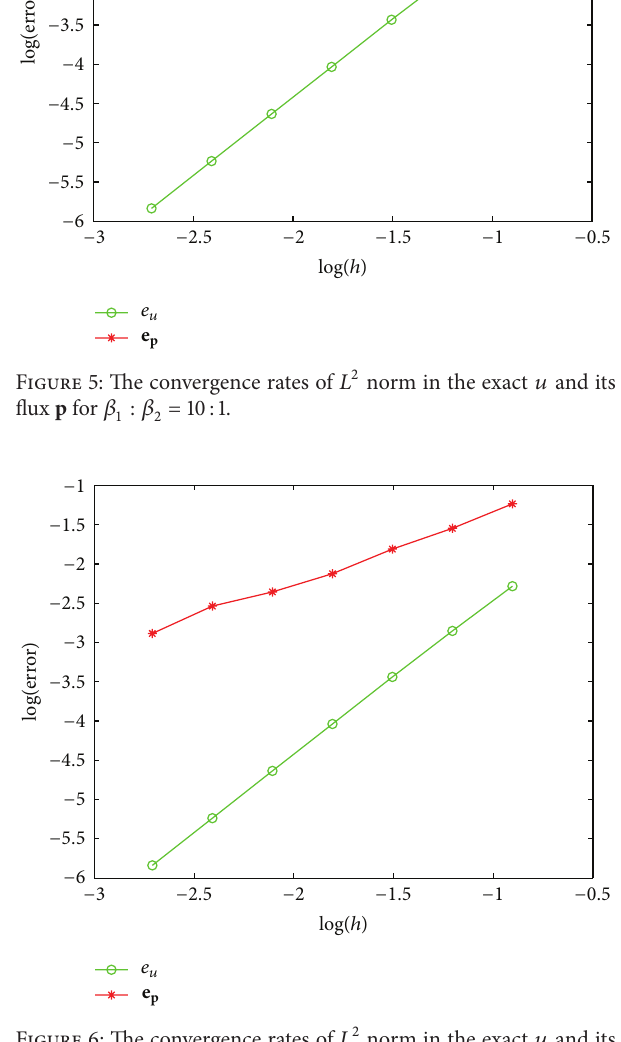
Figure 4: The convergence rates of 𝐿 2 norm in the exact 𝑢 and its flux p for 𝛽 1 : 𝛽 2 = 1: 1000.